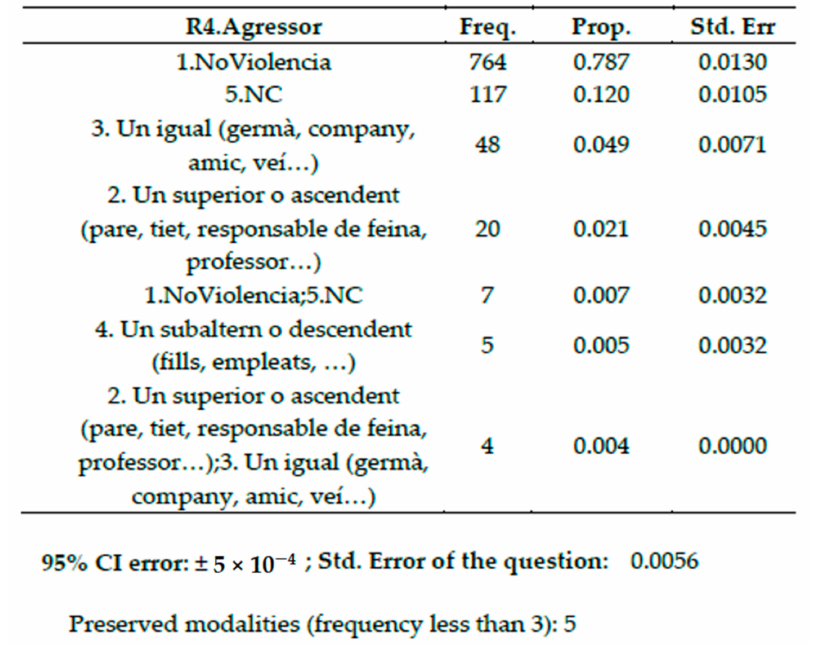
Figure 46. Frequency table of Who is the